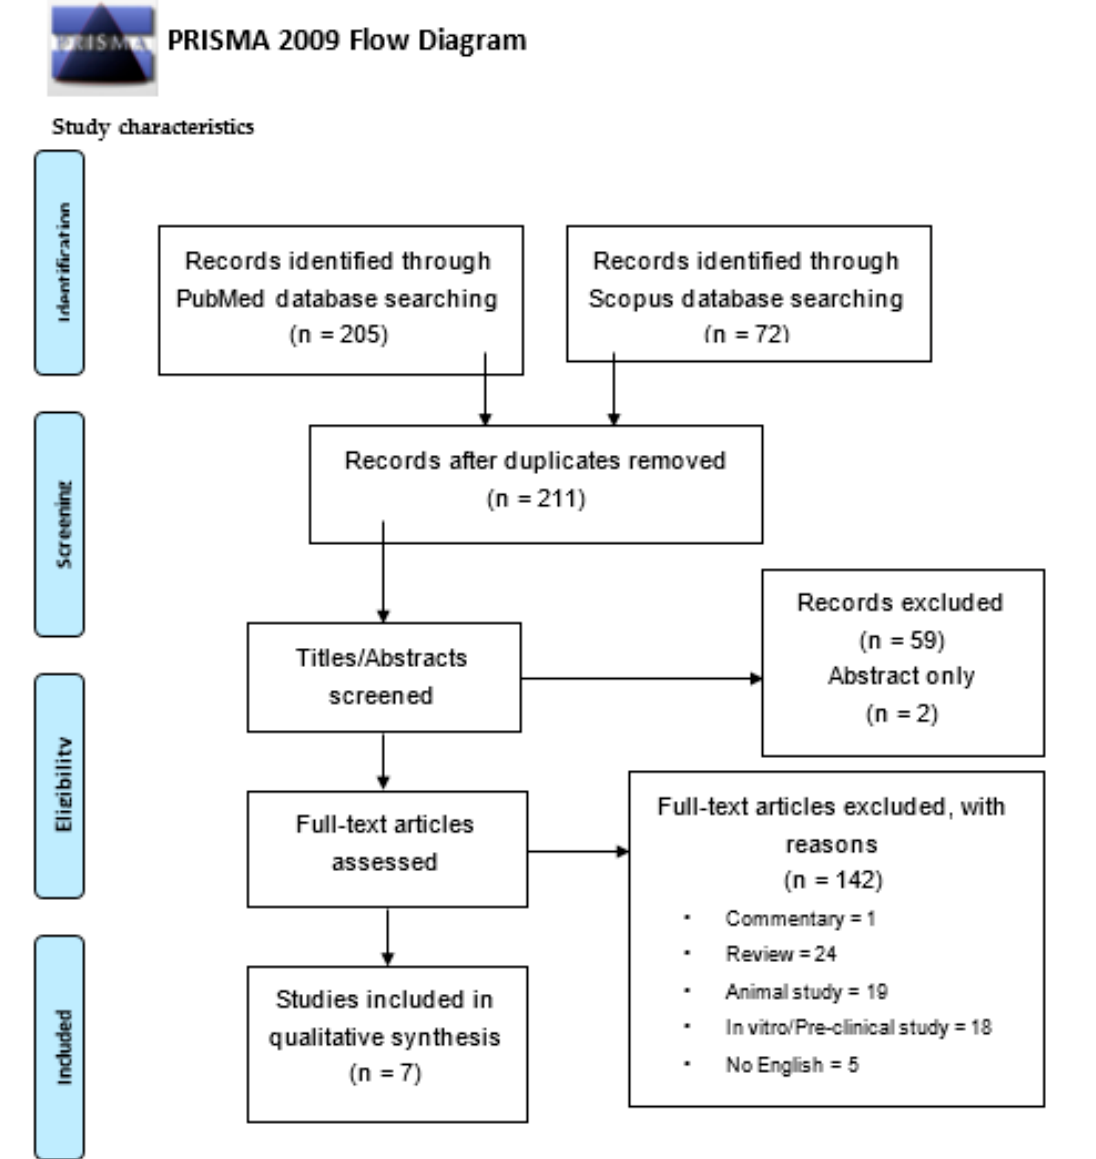
Figure 1. Study selection flow-chart.